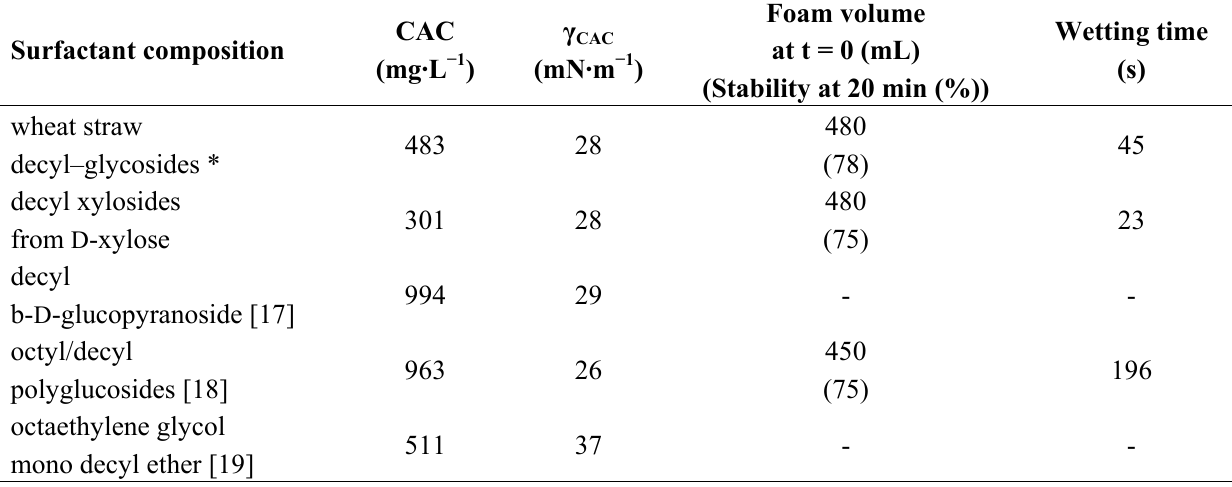
Table 4. Surface properties, foaming and wetting power of glycoside compositions from wheat straw, D -xylose and D -glucose.